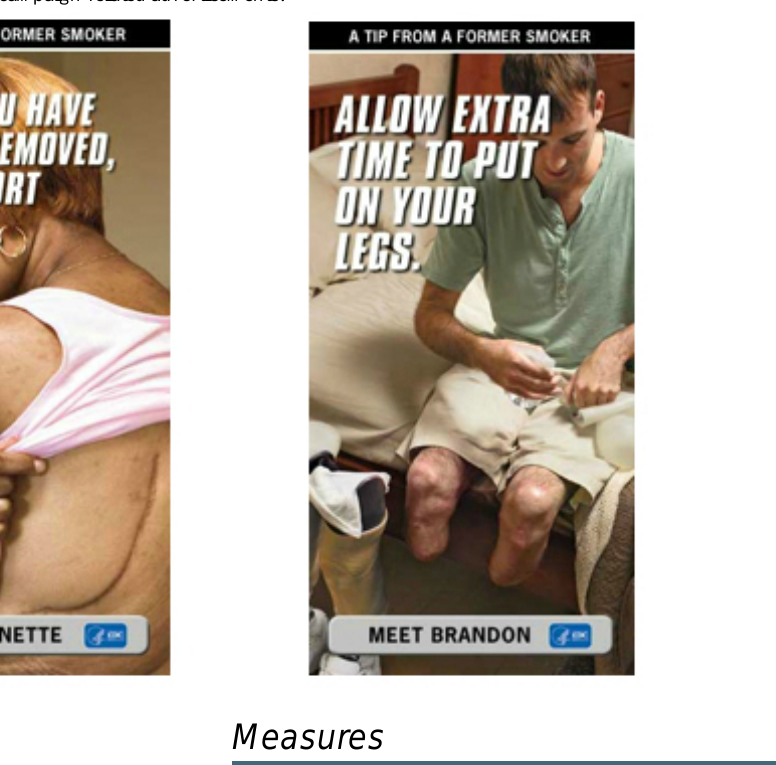
Figure 1. Provides examples of CDC Tips 2012 campaign-related